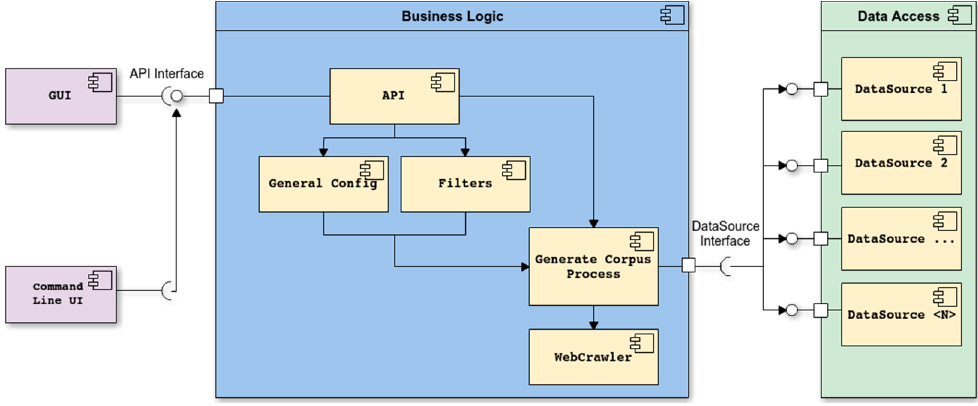
Figure 3. WARCProcessor modular architecture.